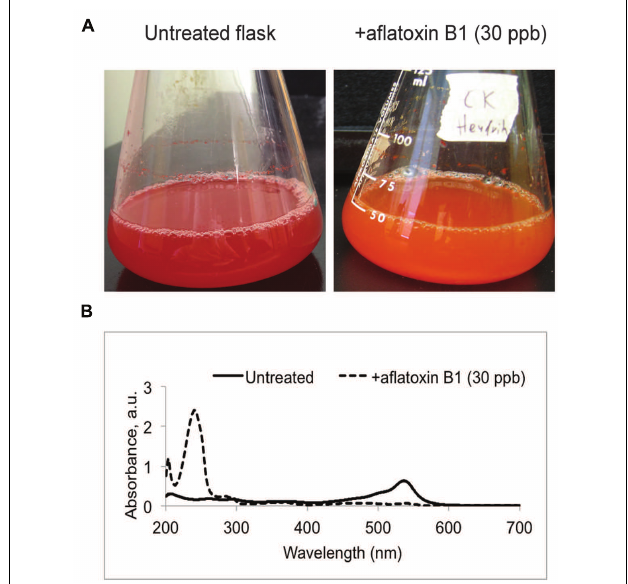
FIGURE 3 | Aflatoxin-response metabolites (ARMs) produced by the bacterium V. gazogenes during exposure to aflatoxin B 1 (AFB1). (A) Representative flasks demonstrating the differences in appearance of untreated V. gazogenes cultures and the aflatoxin B 1 supplemented cultures. (B) Comparison of UV-Vis profiles of the methanol extracts from untreated and supplemented V. gazogenes cultures.